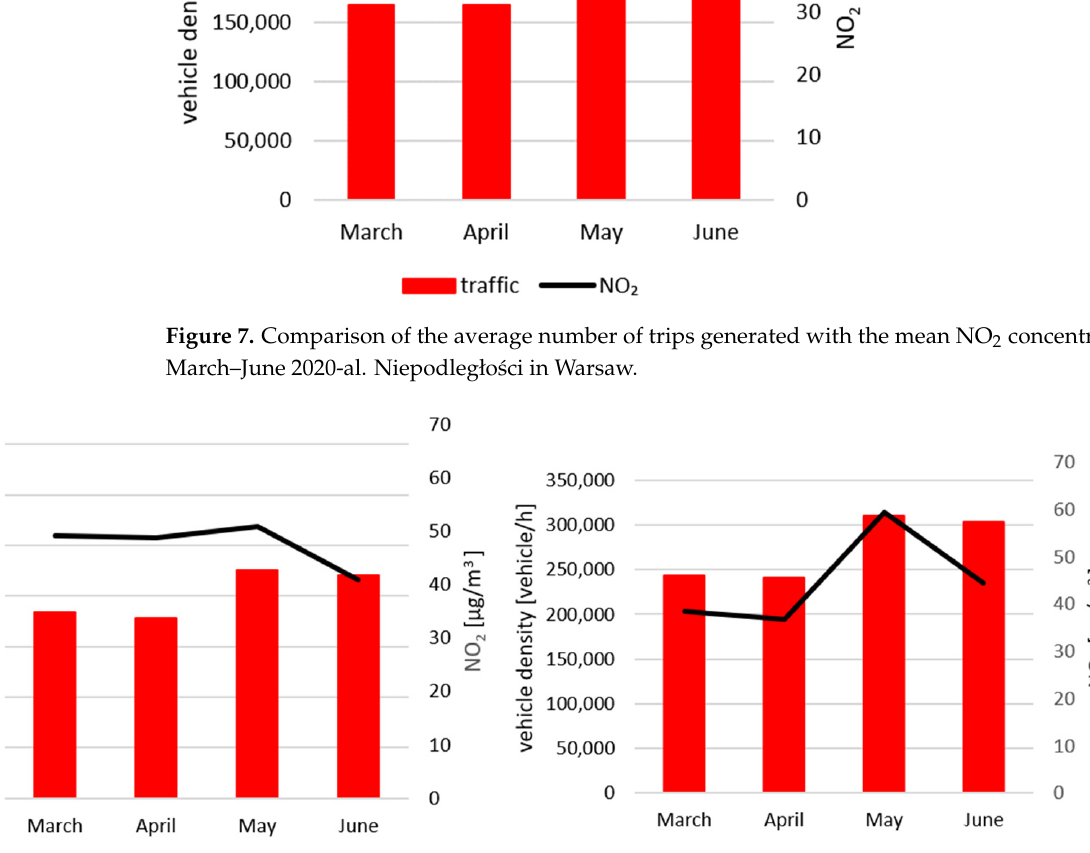
Figure 8. Comparison of the average number of trips generated against NO 2 concentrations calculated as the averages over the peak hours. 2020–al. Niepodleg ł o ś ci.